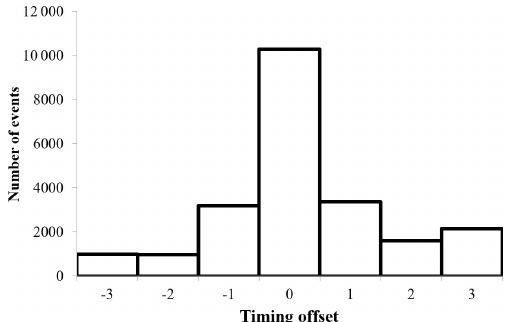
Figure 7. Histogram of the timing offset between observed and sim- ulated peaks for the year